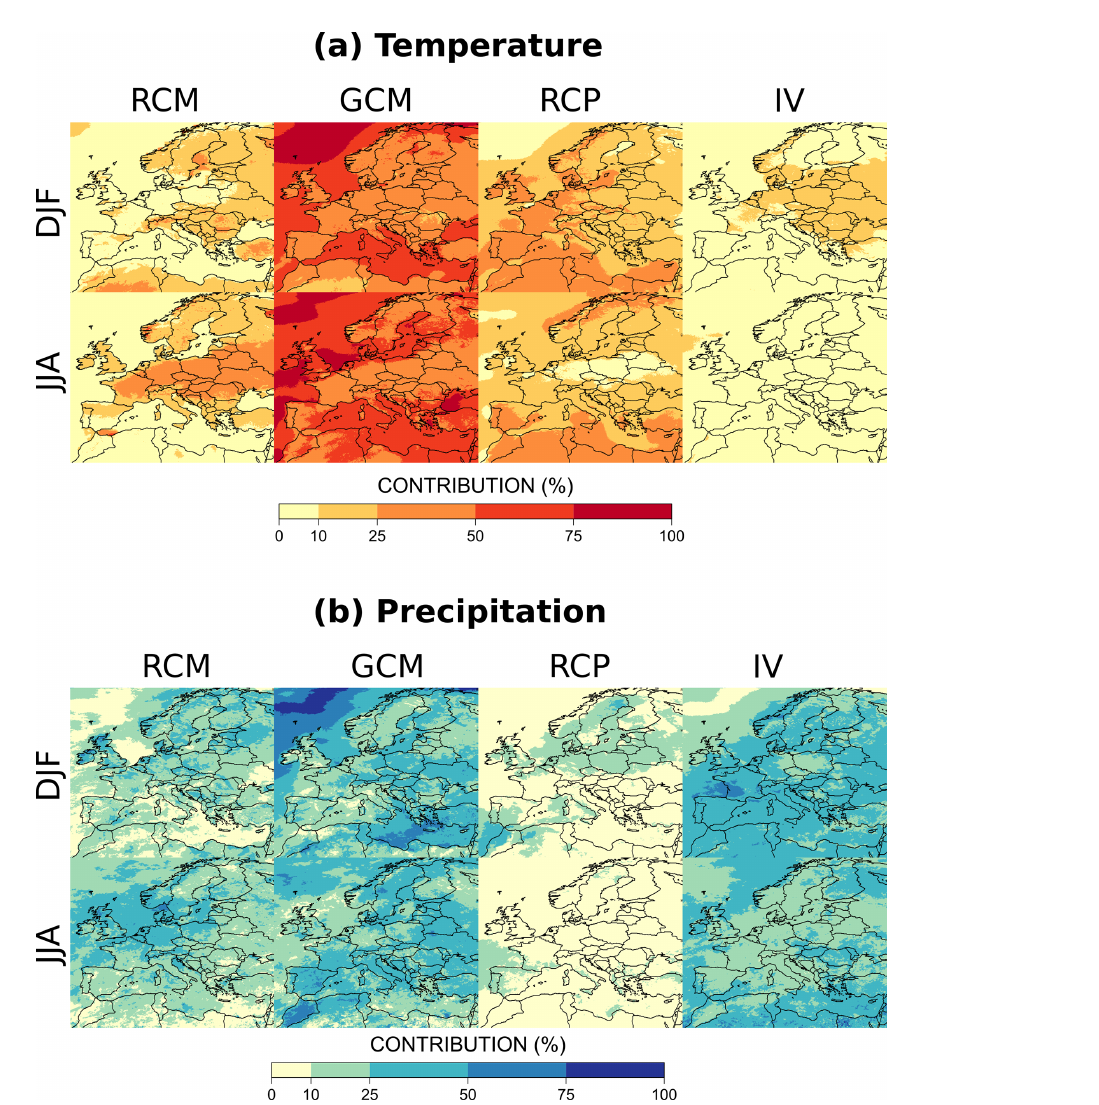
Figure 7. Fraction of total variance explained by the main sources of uncertainty: RCM, GCM, RCP scenario, and internal variability (IV) for (a) absolute temperature changes and (b) relative precipitation changes for the near future (2021–2050) compared to the period